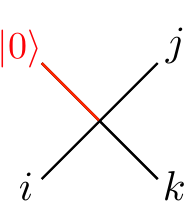
i j k , represented as the projection of a unitary matrix. Such j i ! j ij i